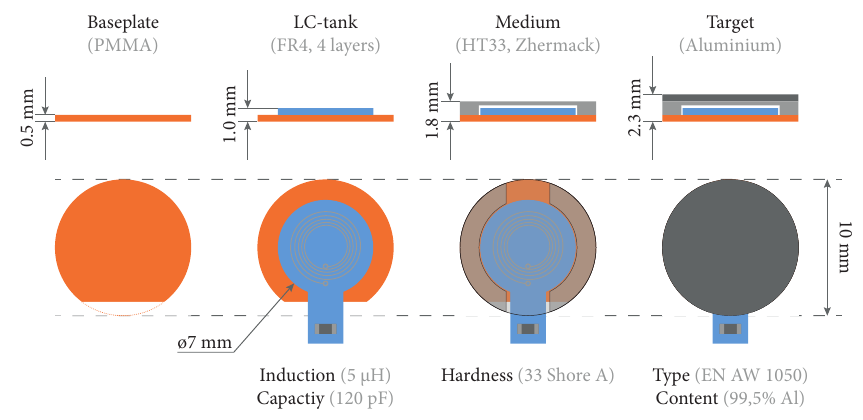
Figure 3. Sensor specifications. Front and top view of the sensor in four stages of the assembly process. The sensor is built out of four parts of which the technical specifications are given